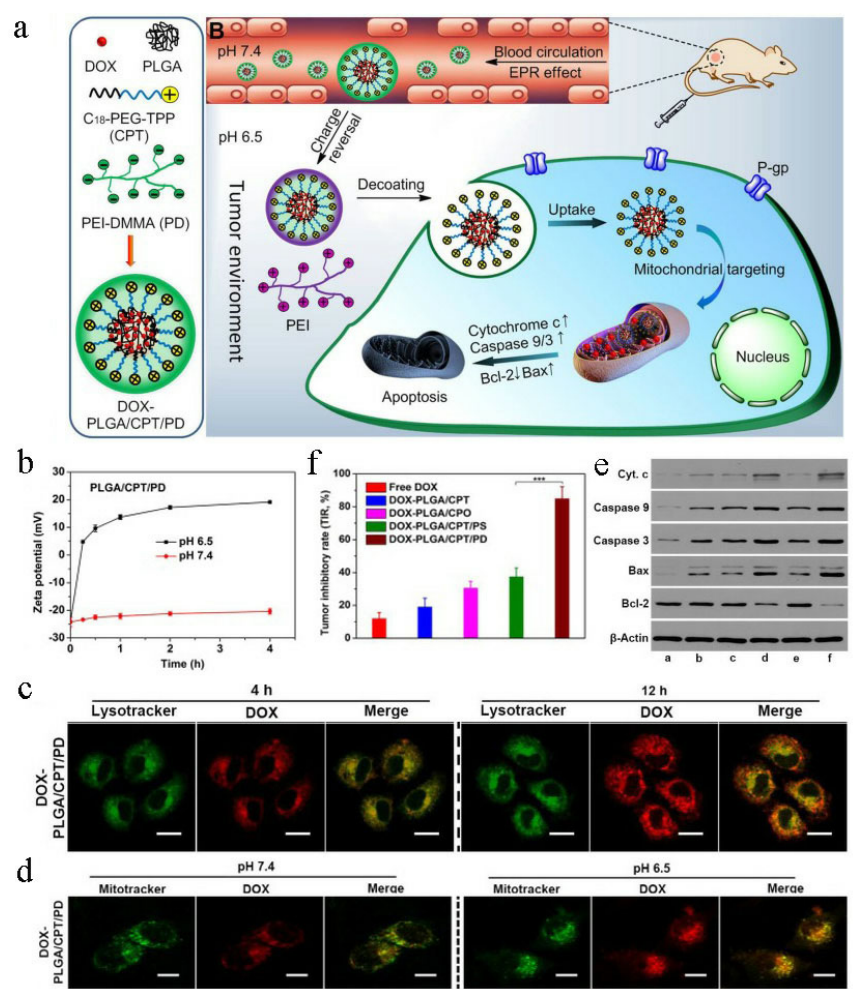
Figure 2. DOX-PLGA/CPT/PD for overcoming cancer drug resistance. Reprinted with permission from Ref. [70]. 2019, NIH. ( a ) Schematic diagram of the mechanism of DOX-PLGA/CPT/PD sur- mounting cancer drug resistance. ( b ) Charge reversal of PLGA/CPT/PD. ( c ) Lysosome escape of PLGA/CPT/PD, scale bar = 20 µ m. ( d ) Mitochondrial targeting capability of DOX-PLGA/CPT/PD, scale bar = 20 µ m. ( e ) Apoptosis mechanism analysis. ( f ) Tumor inhibition of DOX-PLGA/CPT/PD after treatment for 18 days.